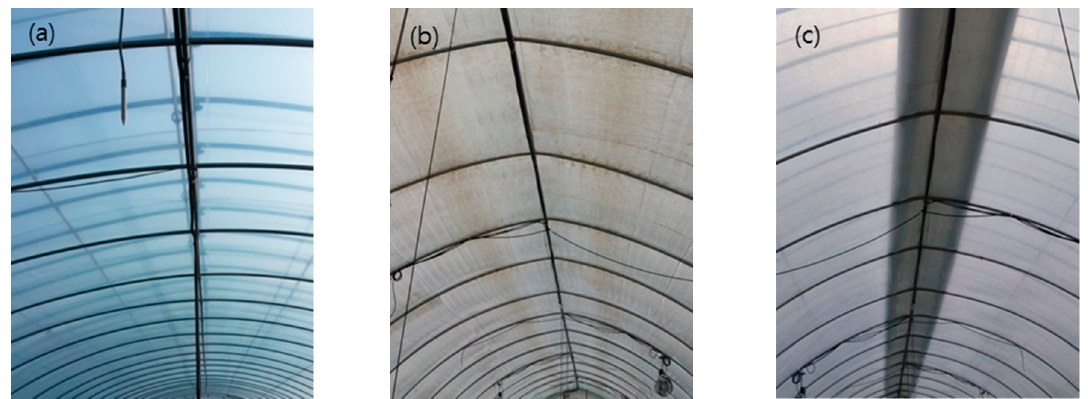
Figure 1. Images of the inside of the greenhouses: ( a ) without thermal curtains, ( b ) with thermal curtains closed over the inner plastic cover, and ( c ) with thermal curtains rolled up to the central beam of the inner cover.